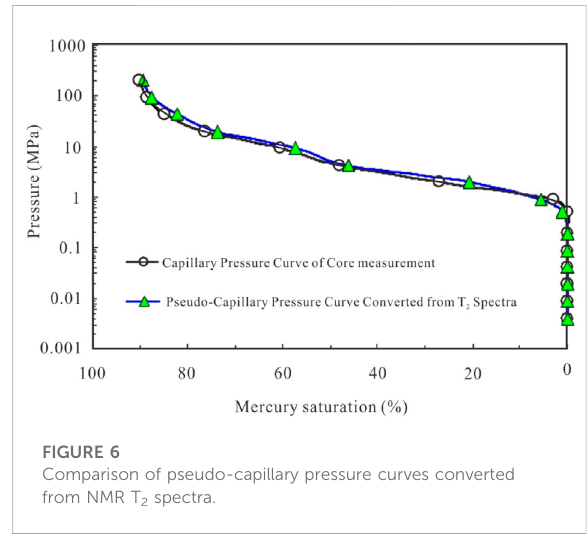
FIGURE 6 Comparison of pseudo-capillary pressure curves converted from NMR T 2